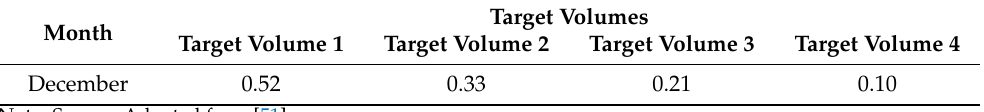
Table 6. Coefficients of the Target Volume.